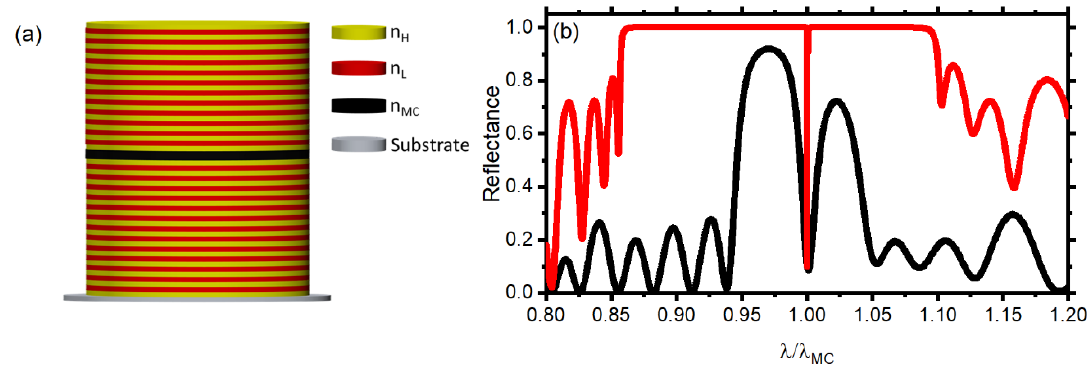
Figure 4. ( a ) Schematic of a planar microcavity structure. ( b ) Calculated reflectance spectra for a PS:CA (black line, ∆ n = 0.11) and a Hy:TiO 2 -PVA (red line, ∆ n = 0.58) microcavity of two DBRs composed of 31 alternated layers with thicknesses of d L = 120 nm and d L = 80 nm. The defect layer has a thickness of d D = 40 nm and refractive index of n MC = 1.5.